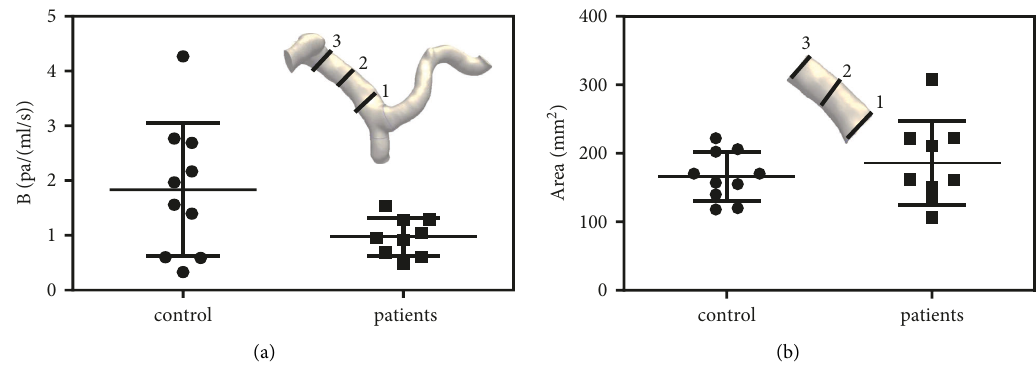
Figure 3: Flow resistance of PV and cross-sectional analysis of MPV. (a) Flow resistance of PV. (b) Cross-sectional analysis of MPV.